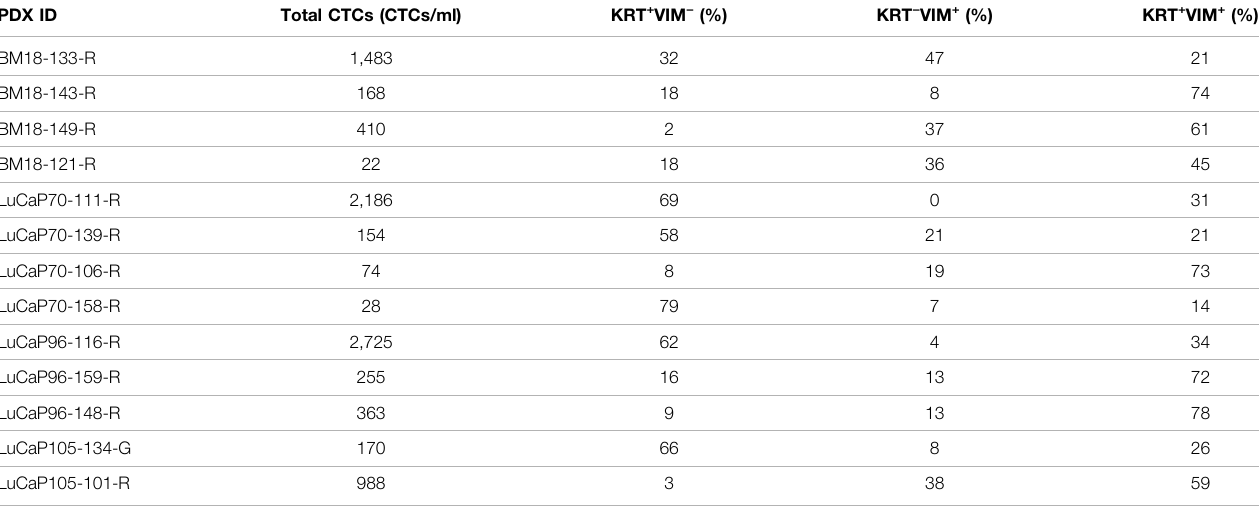
TABLE 1 | Quanti fi cation of cytokeratin/vimentin (KRT/VIM) immuno fl uorescence staining of castrated PDX blood